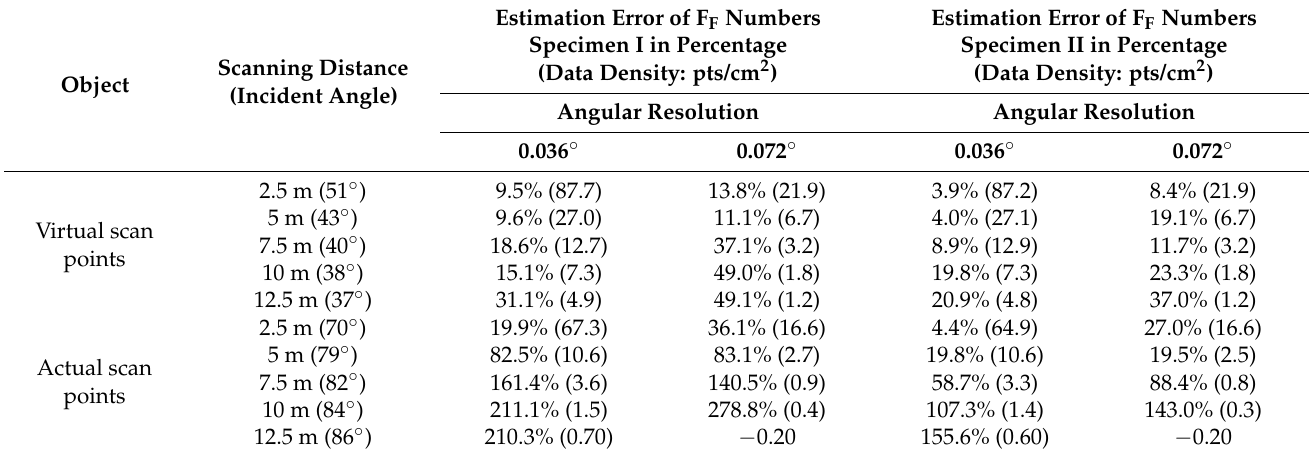
Table 3. Estimation errors for F F numbers under varying angular resolutions and scanning distances.